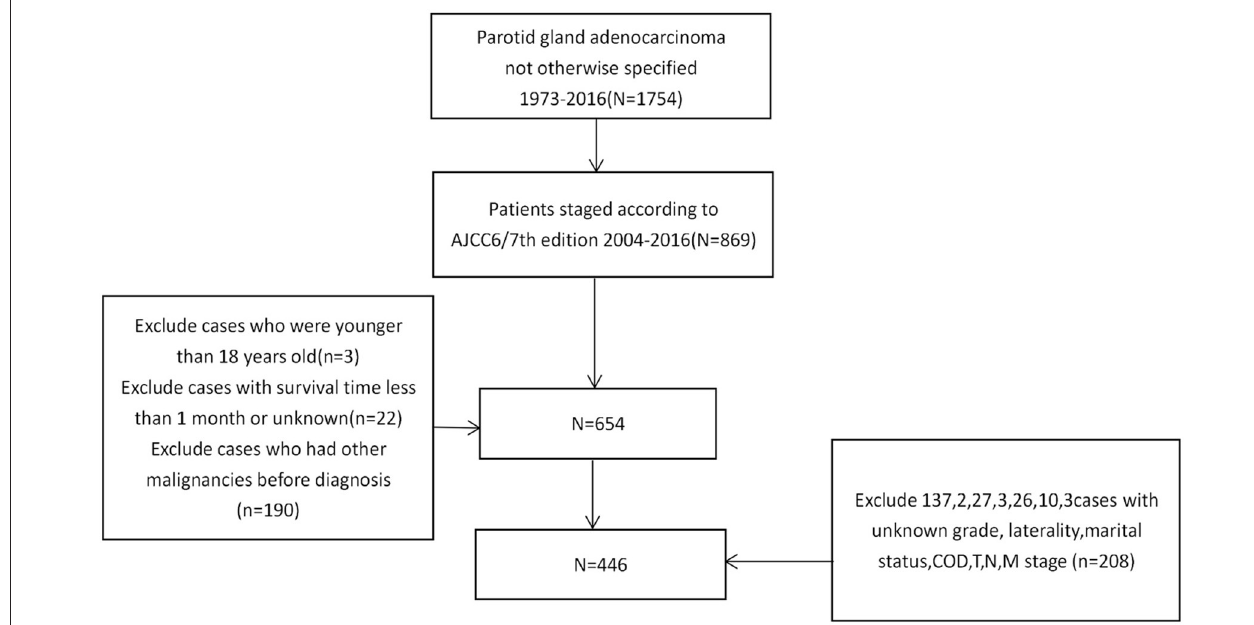
FIGURE 1 | The flow diagram of the selection process for the study